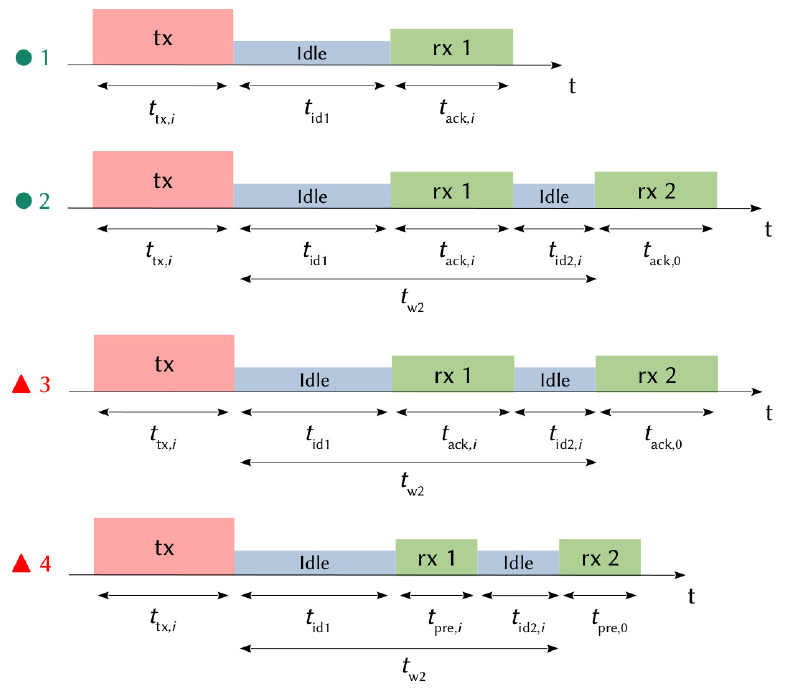
Figure 13. LoRa node state evolution for one transmission.